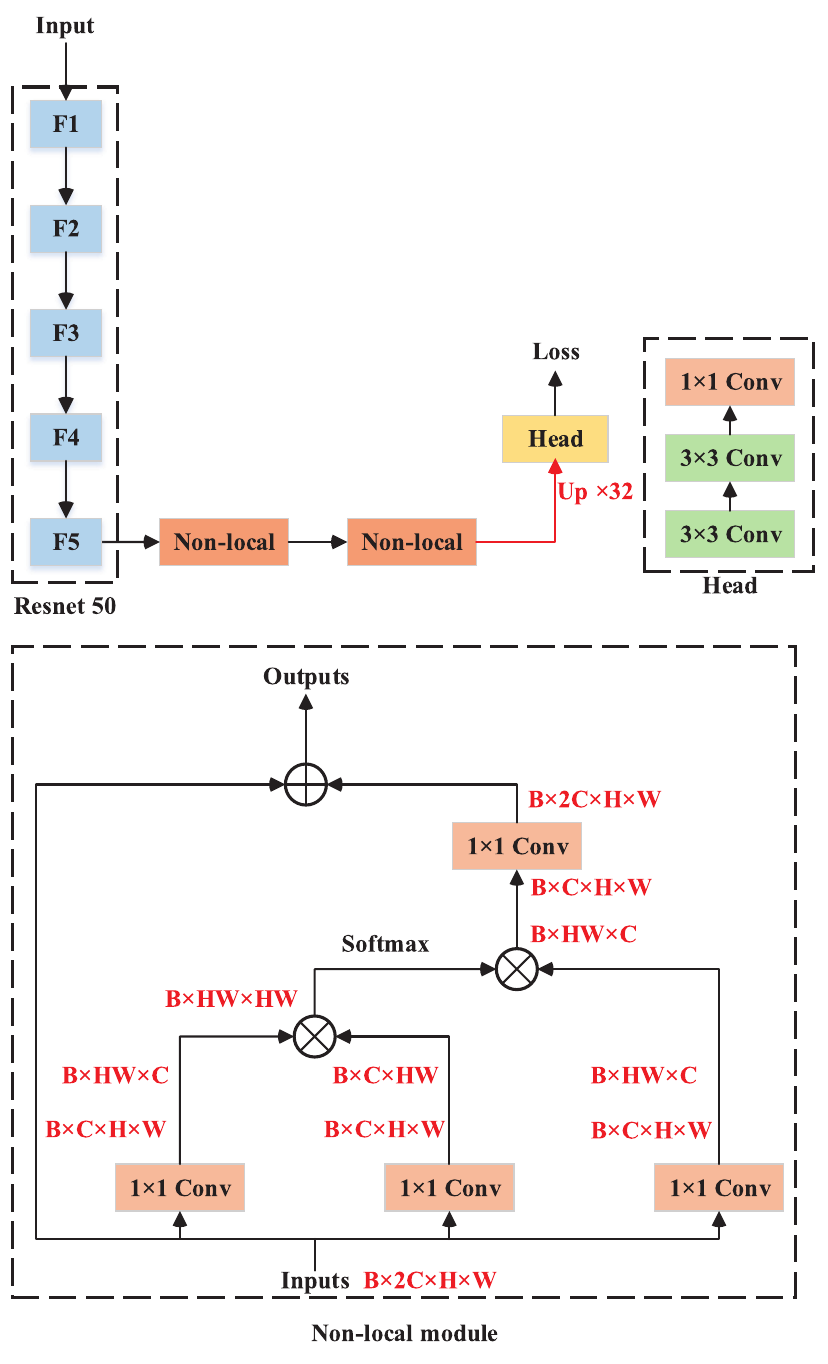
Figure 10. FCN with non-local fusions. B, H, W and C represent batch size, height, width and channel dimension,